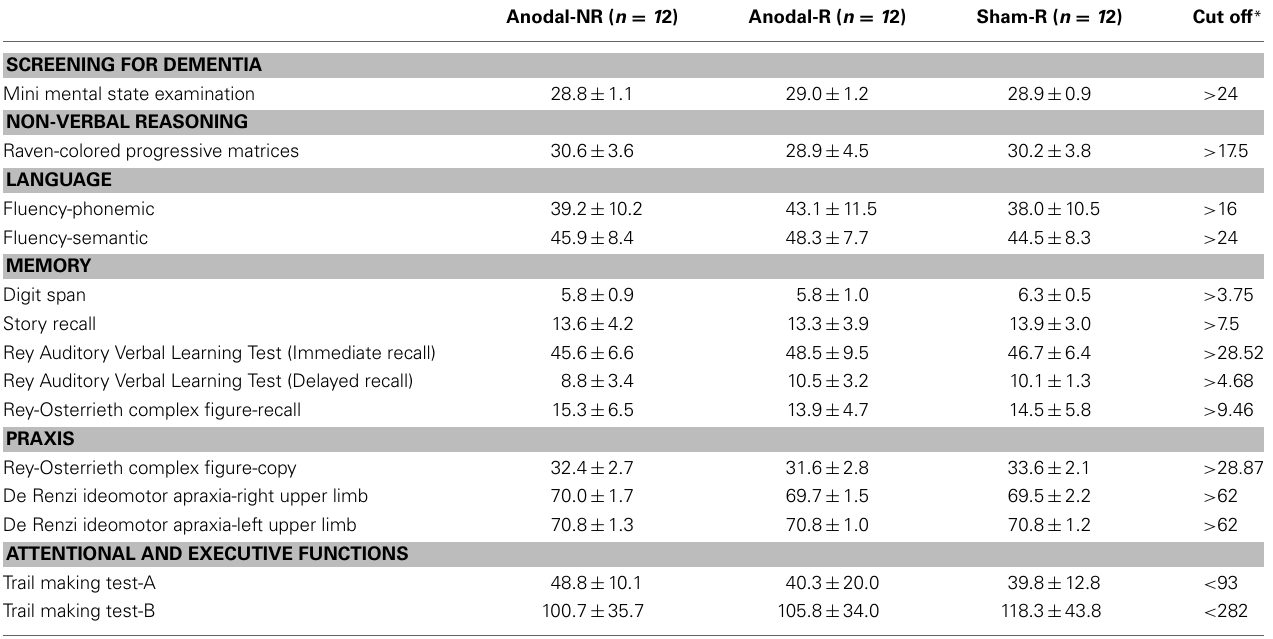
Table 2 | Neuropsychological assessment of older subjects grouped according to the experimental conditions (Anodal-NR; Anodal-R;